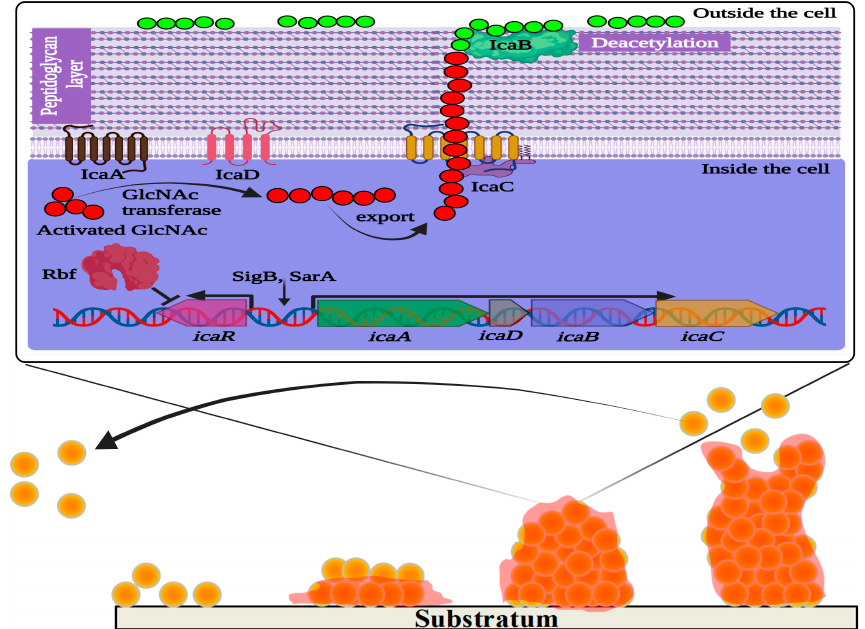
Figure 1. Schematic representation of ica operon regulating PIA-dependent biofilm formation in Staphylococcus aureus . IcaA and IcaD are two transmembrane proteins involved in the synthesis of N-acetylglucosamine (GlcNAc) oligomers that are 15–20 residues in length from activated precursor UDP-GlcNAc units. The growing GlcNAc chain is likely to be exported by another membrane protein named IcaC, which is also suspected to modify PIA molecules. IcaB is an outer membrane protein that generates positive charges in the GlcNAc polymer molecules by deacetylation. The cationic character of PIA is critical for its role in attachment to the anionic bacterial cell surface. IcaR is a repressor protein that controls the expression of icaADBC . Rbf promotes biofilm formation by regulating the expression of icaR . In the lower panel of the figure, the four main stages of biofilm formation are depicted: adhesion, colonization, maturation, and dispersion.